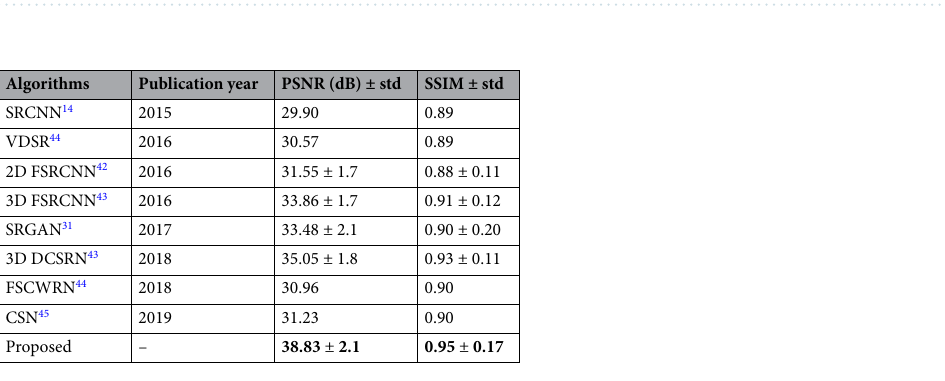
Table 7. Results on BraTS dataset: additional comparison with state-of-the-art methods. Significant values are in [bold].